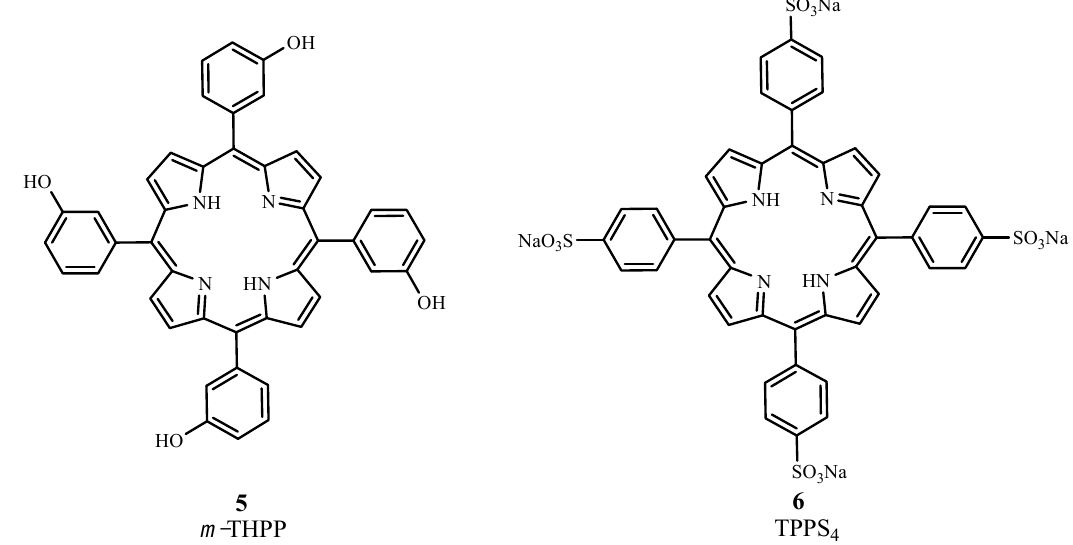
Figure 7. Molecular structures of some second generation